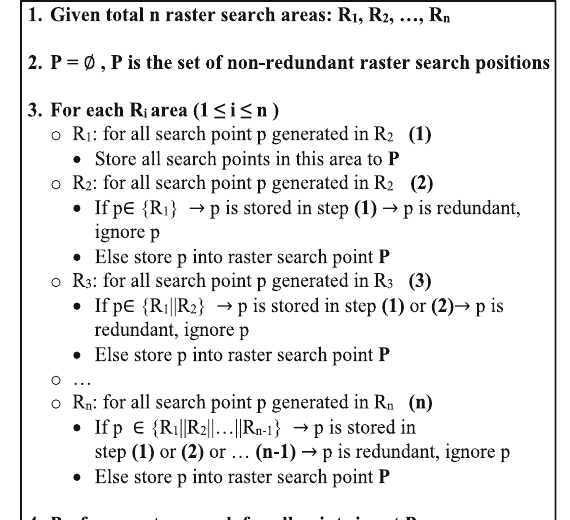
Fig. 11 Search point reduction scheme in the raster search